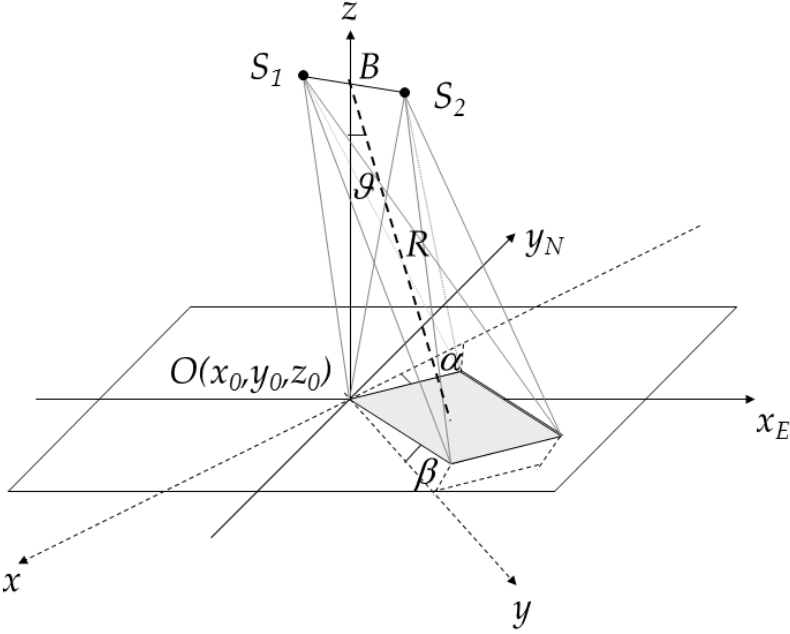
Figure 1. Geometrical configuration of InSAR data acquisition (see text for the definition of variables).